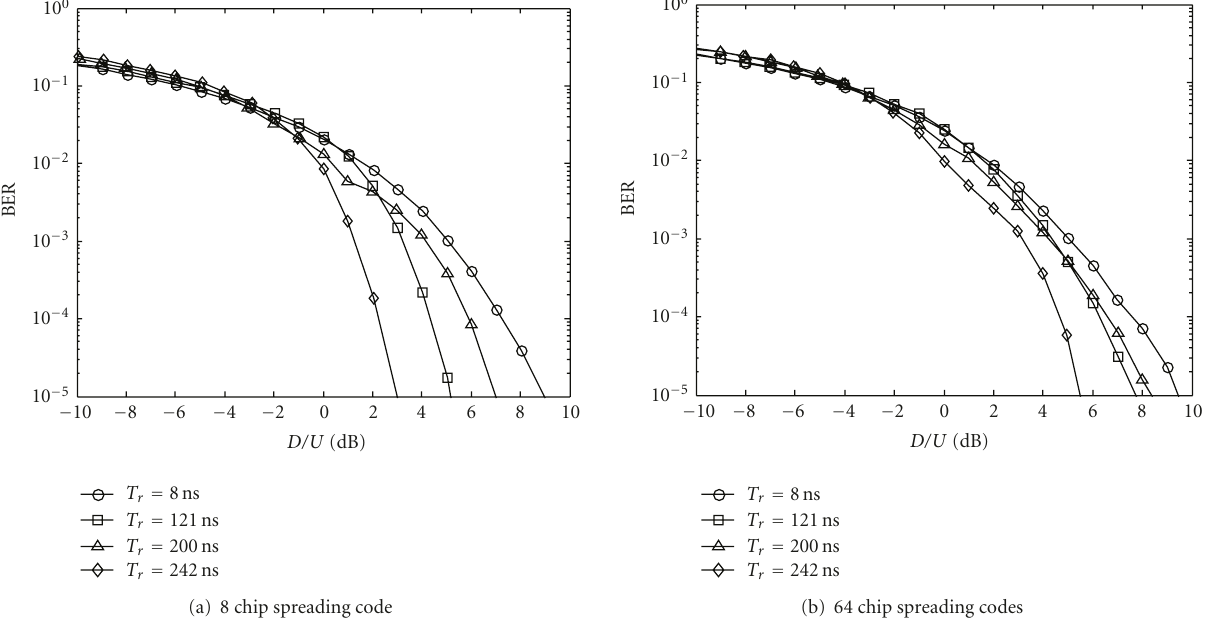
Figure 10: BER performance of OFDM interfered with by DS-UWB ( E b /N 0 = 20dB).